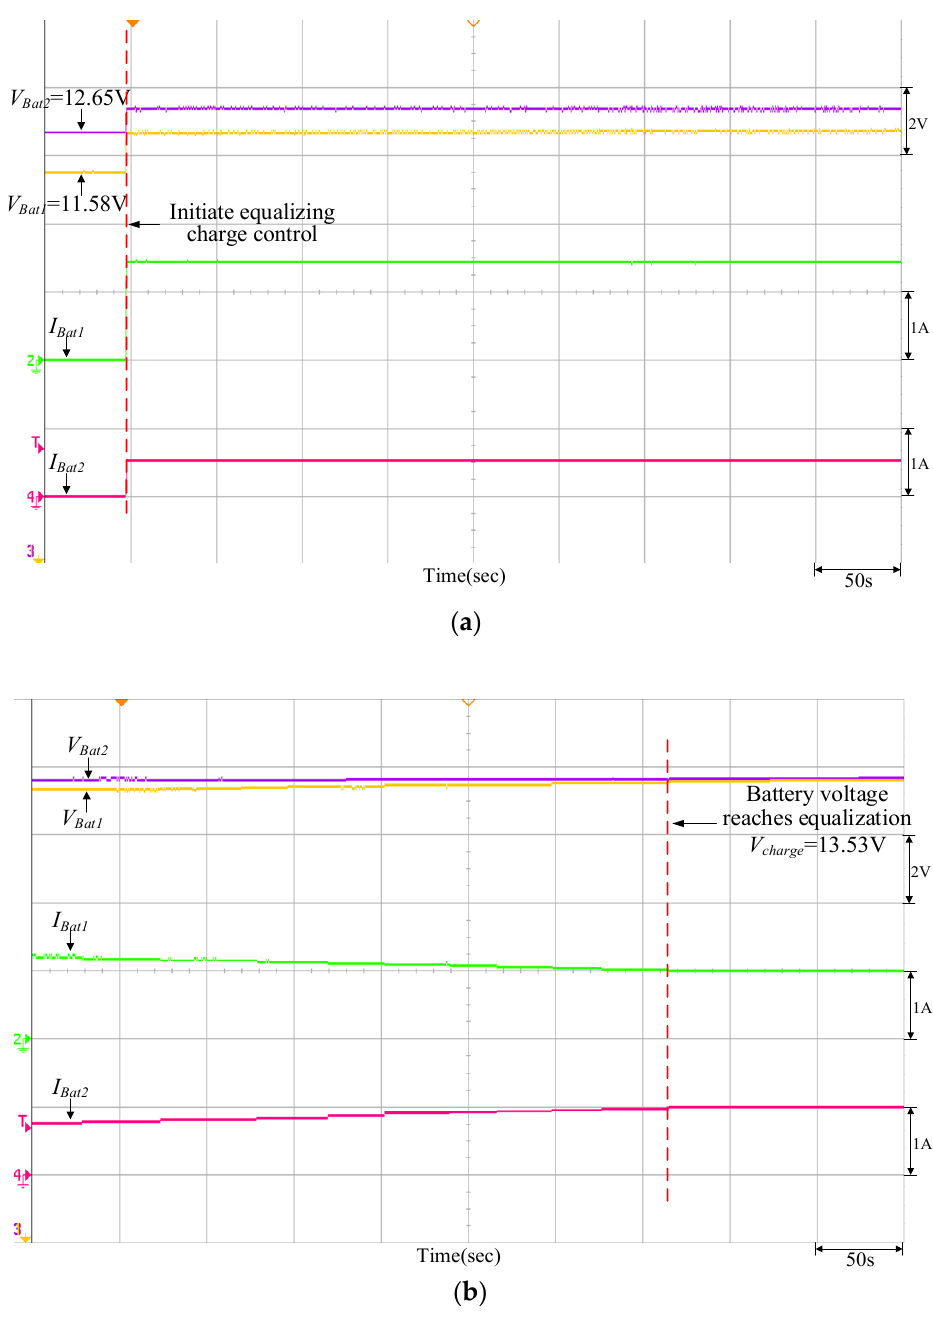
Figure 23. Equalizing charge control response of the traditional P-I controller when V Bat1 = 11.58 V and V Bat2 = 12.65 V: ( a ) initiate equalizing charge control; ( b ) reach equalizing charge equalization.